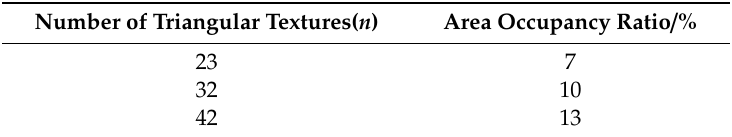
Table 4. Correspondence between the number of triangular micro-textures and the area occupancy ratios of texture